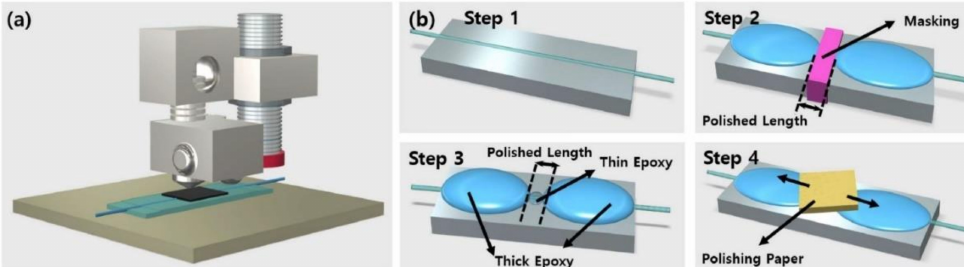
Figure 13. ( a ) Schematic diagram of FDM-based 3D printer. ( b ) Four steps to prepare a side polished fiber suitable for 3D printing. Step 1: Fixing optical fiber onto a V-grooved slide glass. Step 2: masking the target polished fiber section with tape and dropping epoxy on the left-hand and right-hand sides of the taped section to form thick epoxy layers. Step 3: dropping a small amount of epoxy onto the target polished fiber section after removing the masking tape. Step 4: polishing the cladding of the fiber (Reproduced with permission from Reference [140], copyright 2019, IOP Science